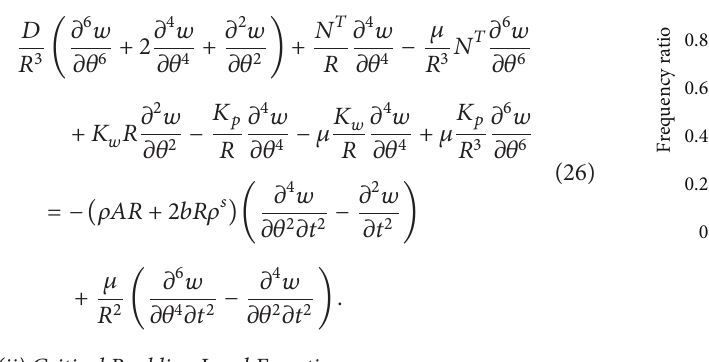
Figure 2: Comparison between the effect of various surface proper- ties on natural frequency with respect to thickness ℎ (nm).